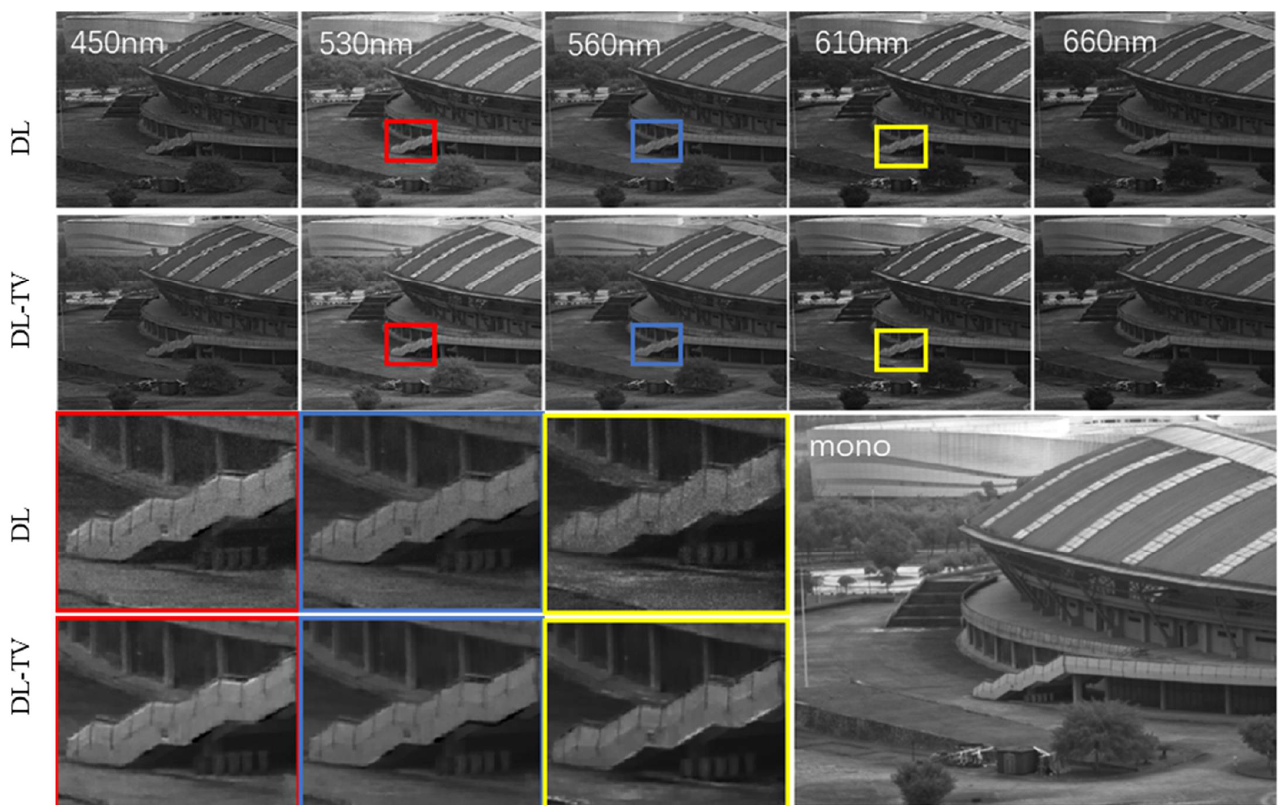
Figure 8. Field test results obtained by the proposed multispectral imaging system. The reconstructed MSIs were calculated using the DL and DL-TV algorithms. A total of 5 of the 31 reconstructed spectral images, with central wavelengths of 450, 530, 560, 610, and 660 nm, were selected and are shown. The zoomed-in regions from three selected spectral images are displayed, along with a captured monochromatic reference